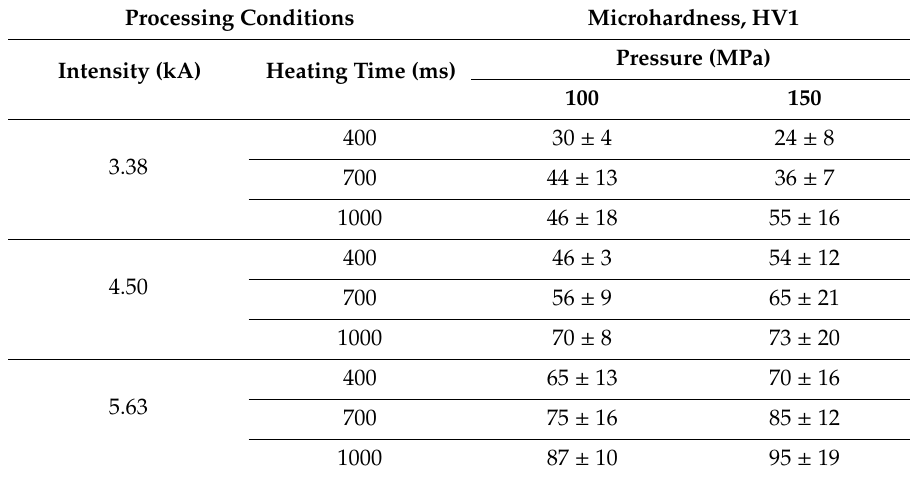
Table 3. Microhardness (HV1) mean values and standard deviations calculated from five measurements at the di ff erent 9 mm MF-ERS